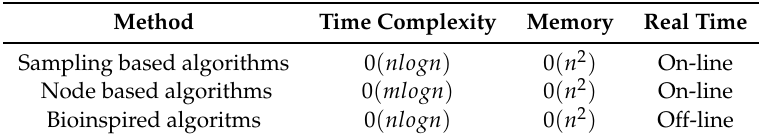
Table 1. Computational cost and complexity in the graph structure, where n is the number of vertex and m is the number of